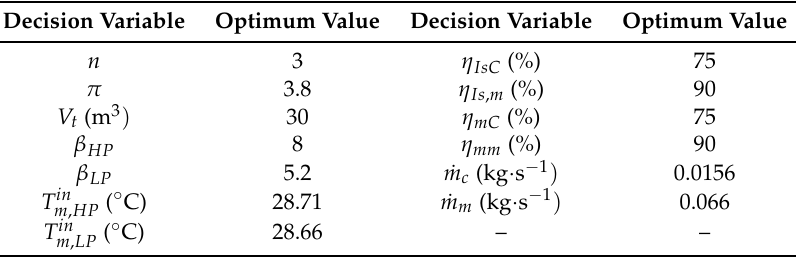
Table 6. Optimal parameters from